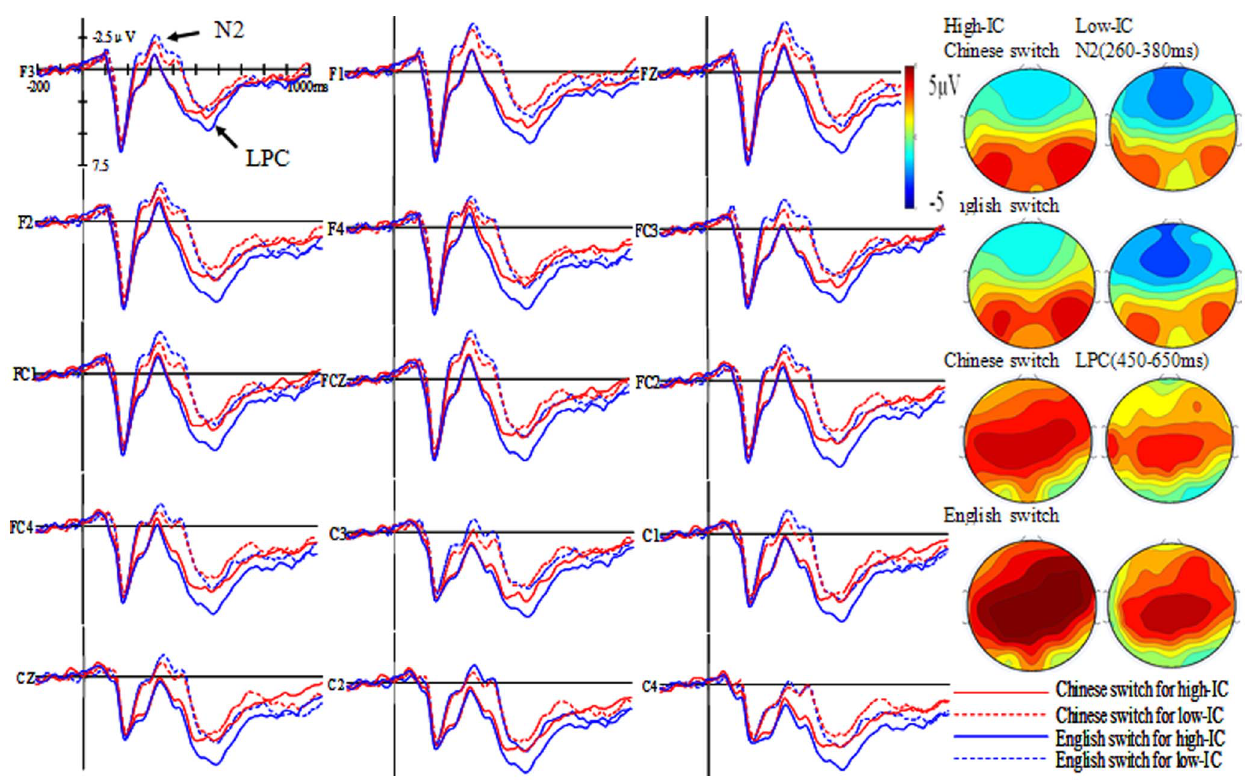
Figure 3. Grand average waveforms and topographic maps for L1 and L2 switch trials for the high and low inhibitory control (IC)